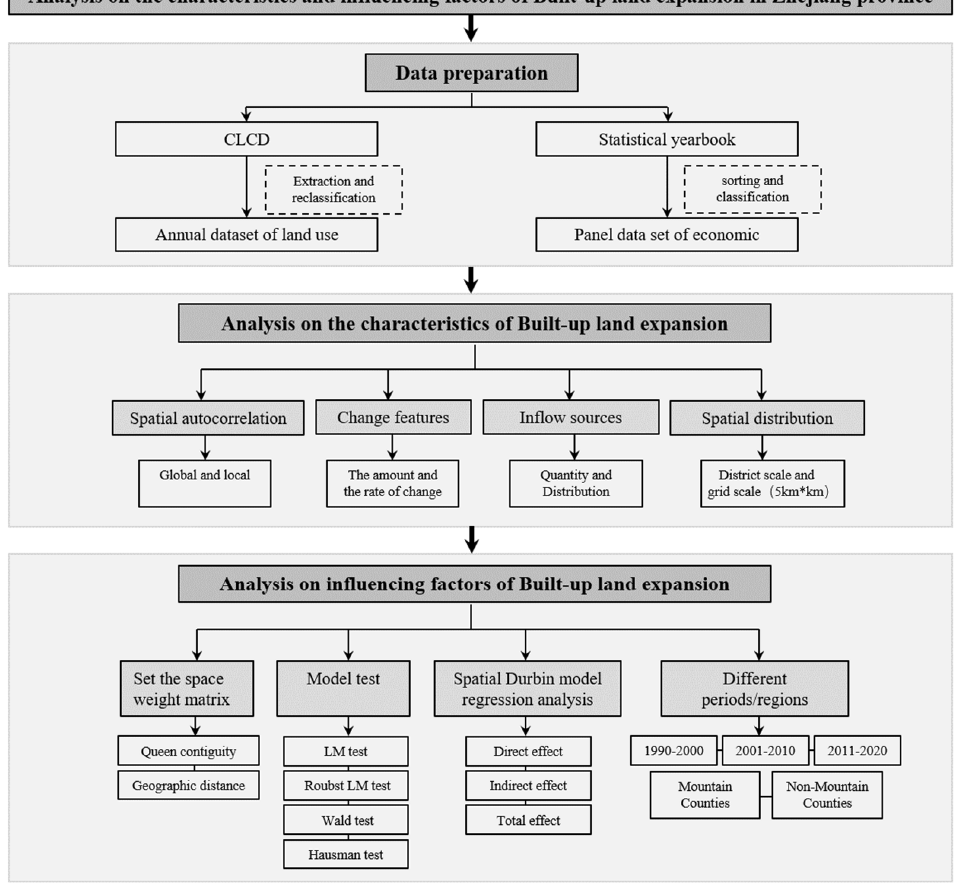
Figure 2. Structure of the